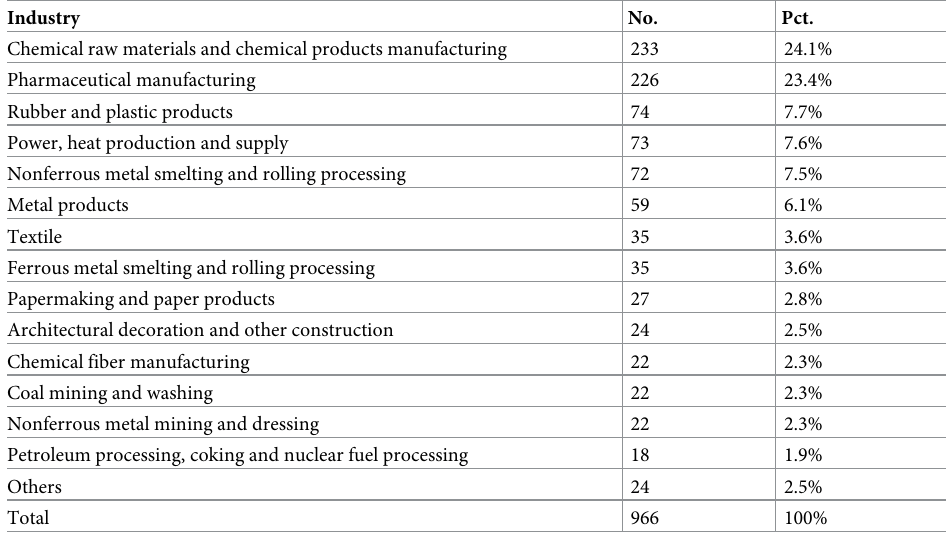
Table 1. Sample distribution by